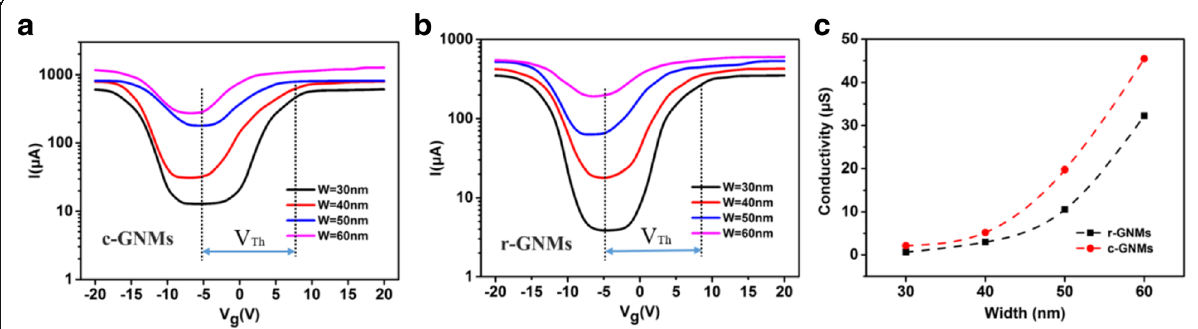
Fig. 4 Transfer characteristics ( I ds − V g ) of the devices based on a c-GNM and b r-GNM with different widths at V ds = 2 V. The V Th (the conduction voltage value minus the voltage value of neutral point) of the 30-nm device is about 15 V. c Conductivity versus the neck width for r-GNM (black) and c-GNM